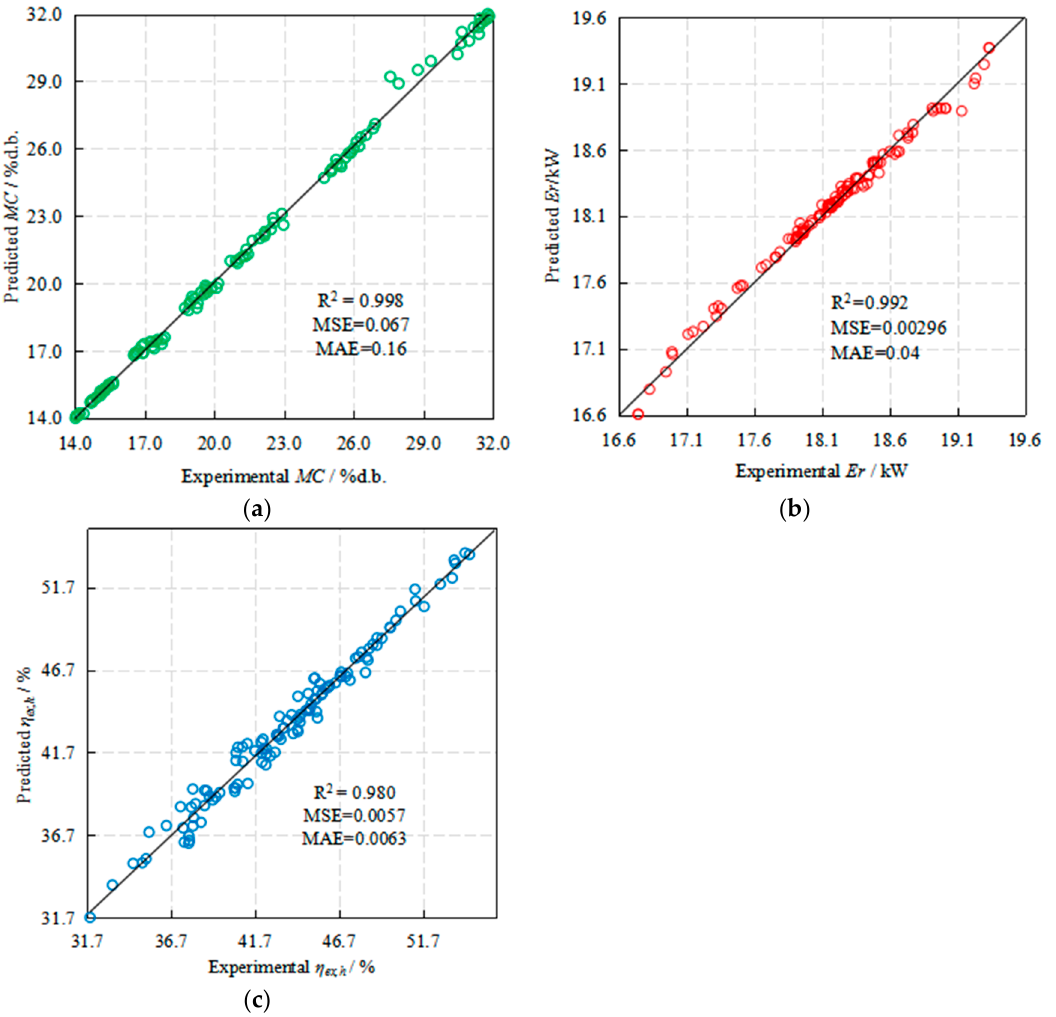
Figure 9. The comparison of experimental values and predicting results for the MC ( a ), Er ( b ), and η ex,h ( c ).